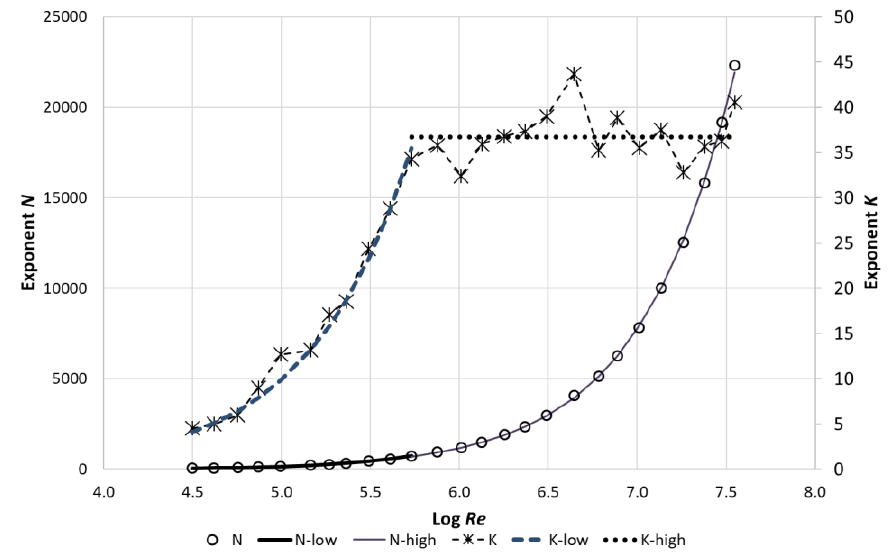
Figure 19. The dependence of K and N exponents on the Re .